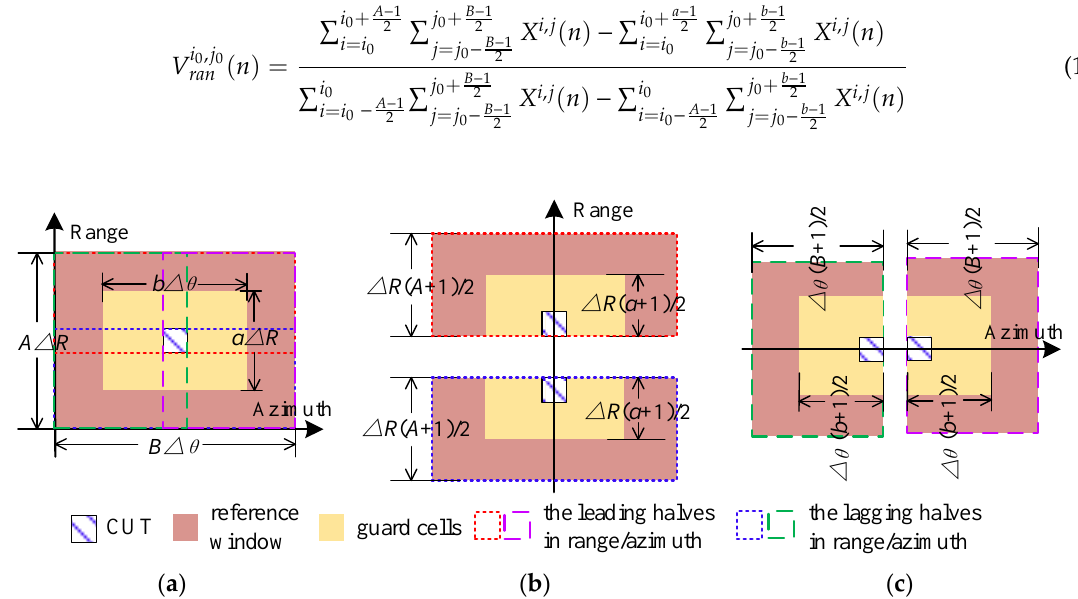
Figure 3. Reference window division for variability indexes (VIs): ( a ) Such a reference window sized 𝐴∆𝑅 × 𝐵𝜃 is divided into two pairs of halves highlighted by different dotted lines; ( b ) Division in range, each half is (𝐴 + 1)∆𝑅 2⁄ wide; ( c ) Division in azimuth, with two (𝐵 + 1)𝜃 2⁄ -width halves.